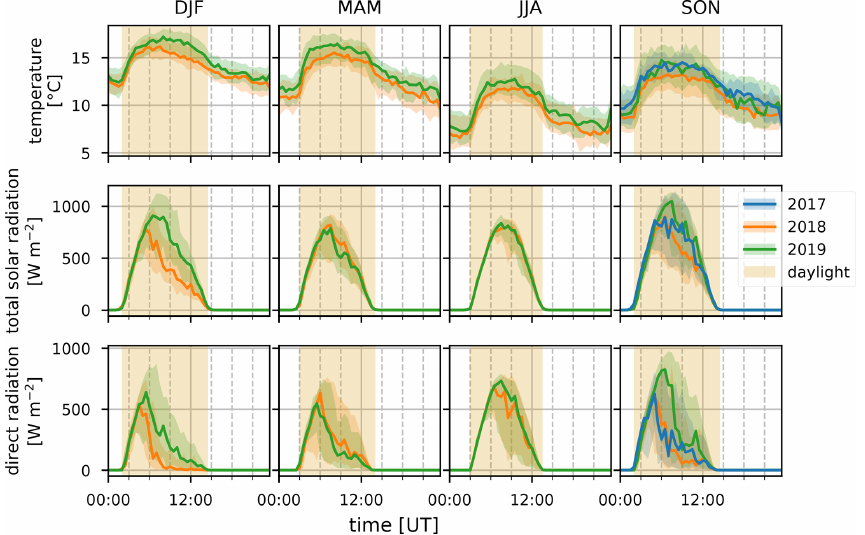
Figure 6. Median diel profiles (lines) and the interquartile distance (shaded area) for the DJF, MAM, JJA, and SON seasons (columns, left to right) in 2017, 2018, and 2019 (blue, orange, and green curves, respectively) for temperature, total solar radiation, and direct radiation (rows, top to bottom). The yellow shaded area illustrates daylight during the respective seasons.